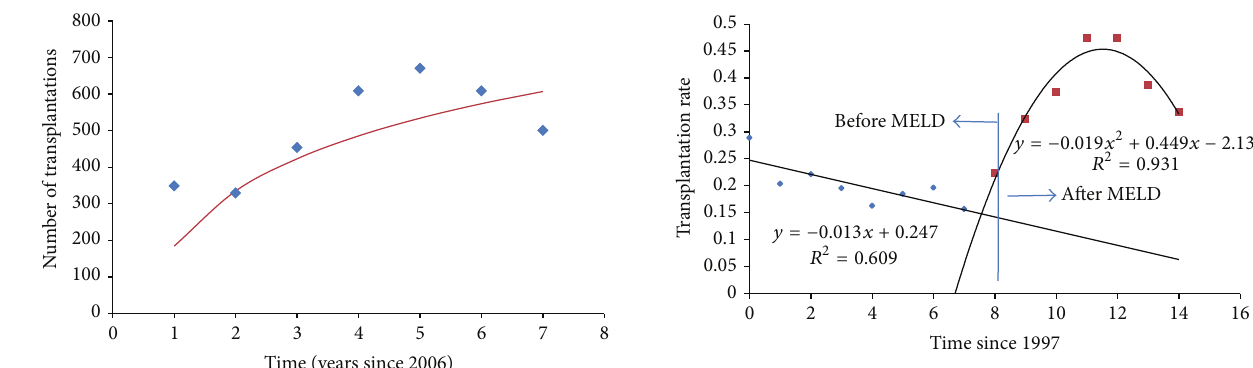
Figure 4: Transplantation rate (proportion of those patients trans- planted with respect to those who enter the waiting list per time unit), comparing the pre- and post-MELD